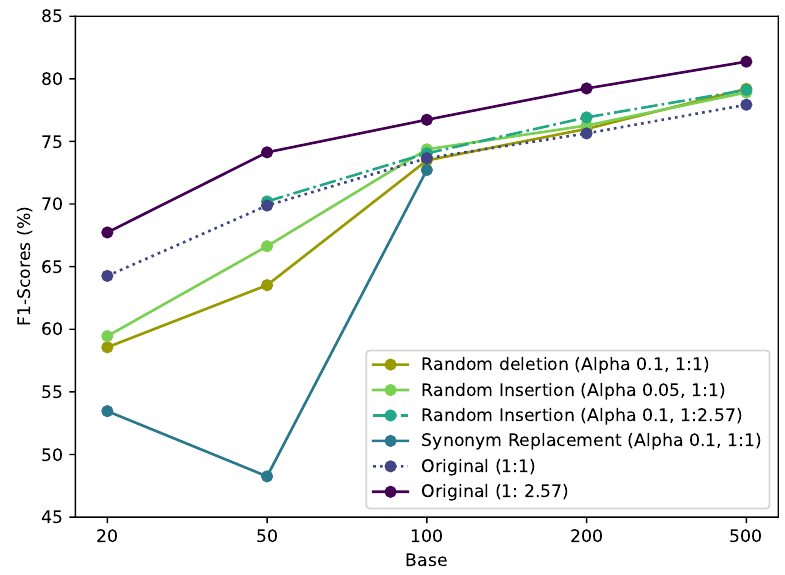
Figure 6. Overall comparison of different text augmentation methods with original data.